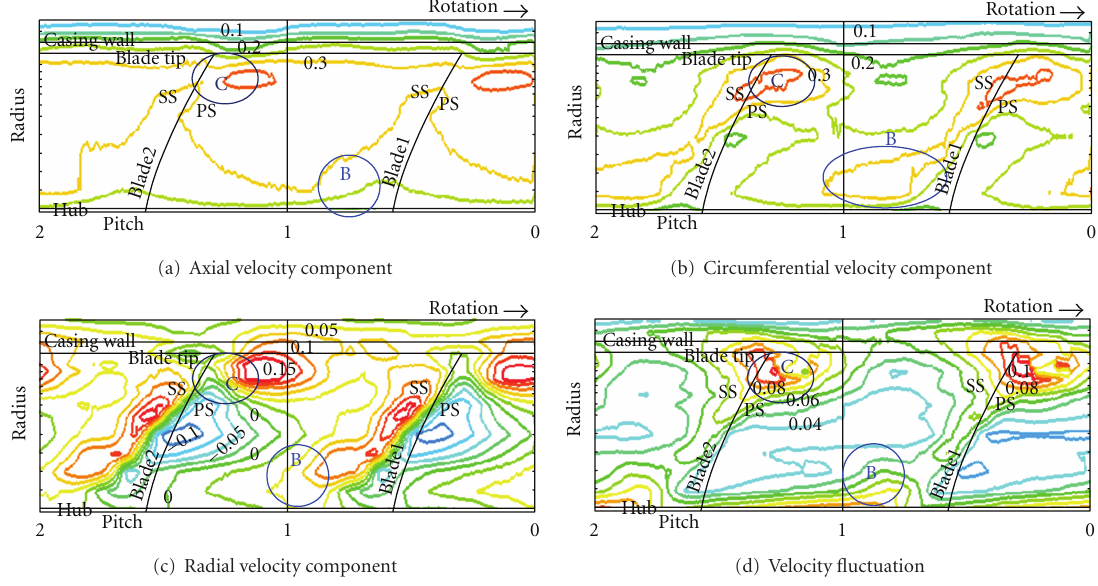
Figure 9: Contour maps of each velocity component and velocity fluctuation at rotor outlet of TypeB at φ = 0 .